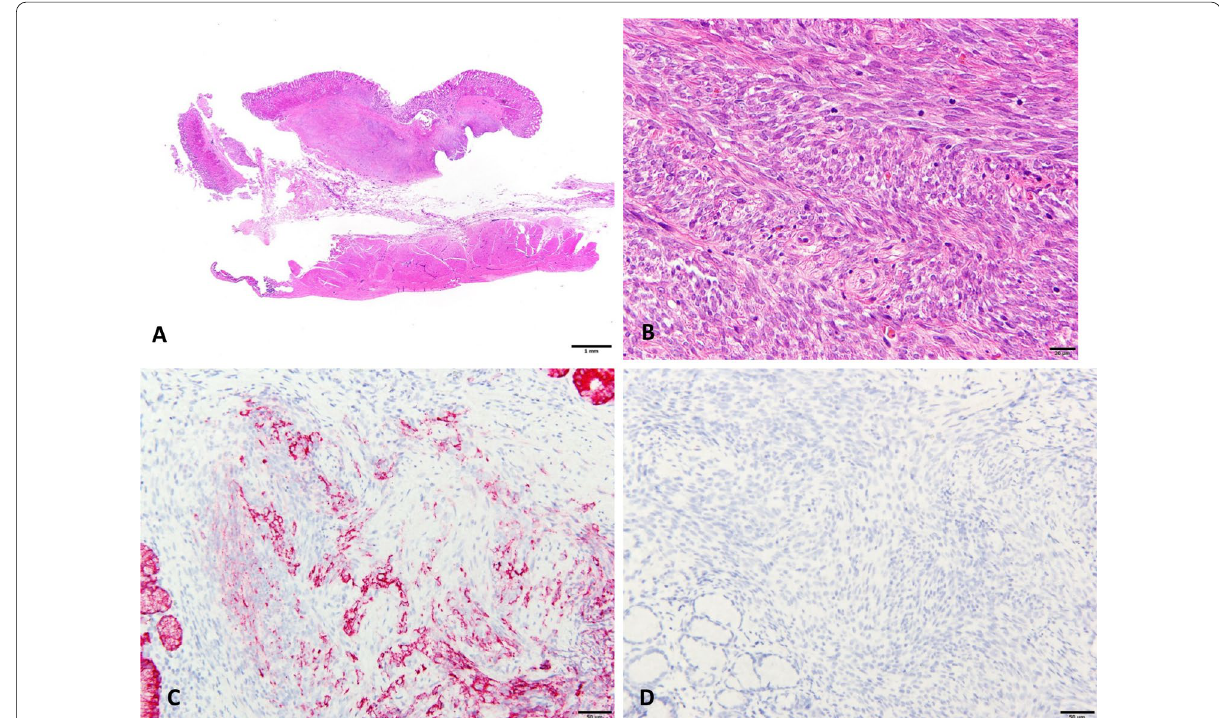
Fig. 3 Pathological findings of the tumor. A Whole-mount view of the cut section of the tumor. The tumor was mainly located in the submucosal tissue (hematoxylin and eosin [H&E] stain). B The tumor is composed of a highly cellular fascicle of short spindle cells. (H&E stain, original magnification, 400). C Immunohistochemical stain using an EMA antibody showed cytoplasmic positivity. (Original magnification, × DOG-1 expression in spindle cells. (Original